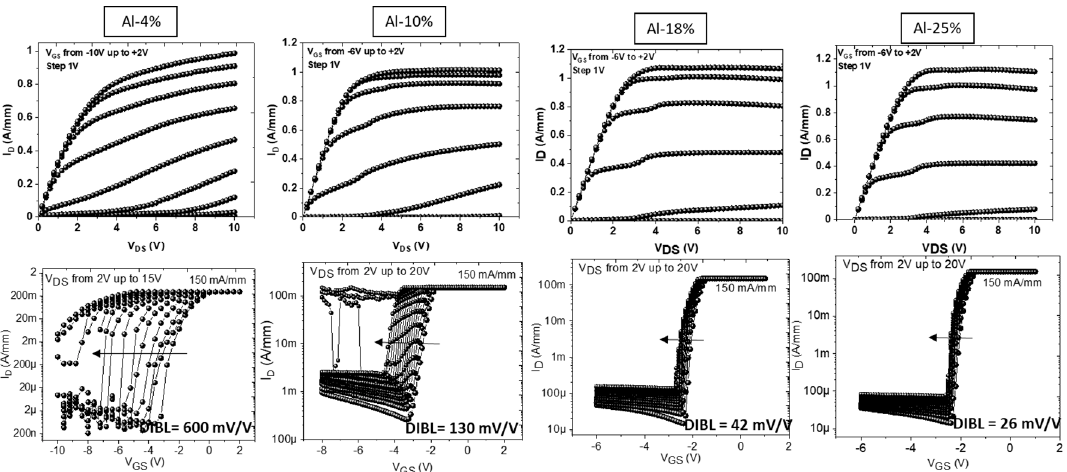
Figure 2. Output and transfer characteristics from V DS = 2 V up to 20 V of 2 × 50 µm AlN/GaN HEMTs for L GD = 0.5 µm and L G = 100 nm with various Al-content in the AlGaN back barrier.